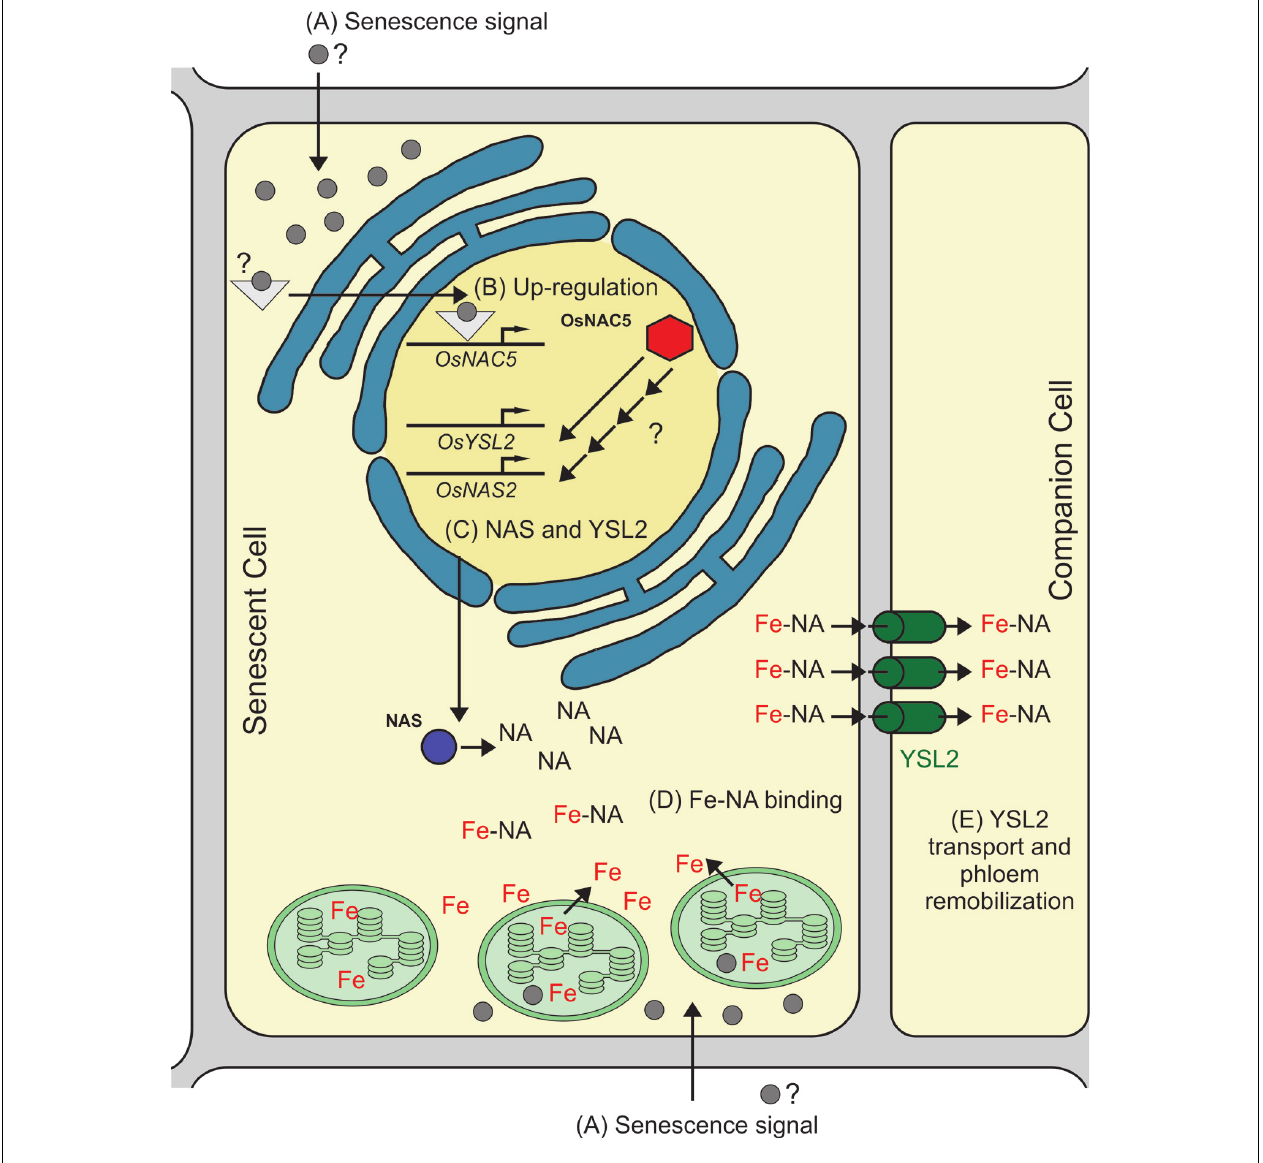
the work performed by Jeong etal., 2013).The increased transcription observed is either directly or indirectly regulated by OsNAC5. (D) OsNAS2 protein increases intracellular NA concentration, which in turn chelates free Fe coming from chloroplast and other cellular components degradation. (E) The Fe–NA complex is transported across the plasma membrane of the senescent cell, and then transported into phloem by OsYSL2, which allows Fe–NA complex long distance translocation. It is important to point the possibility that Fe and NA are exported independently from the cell, interacting in the apoplast and then transported into the phloem by